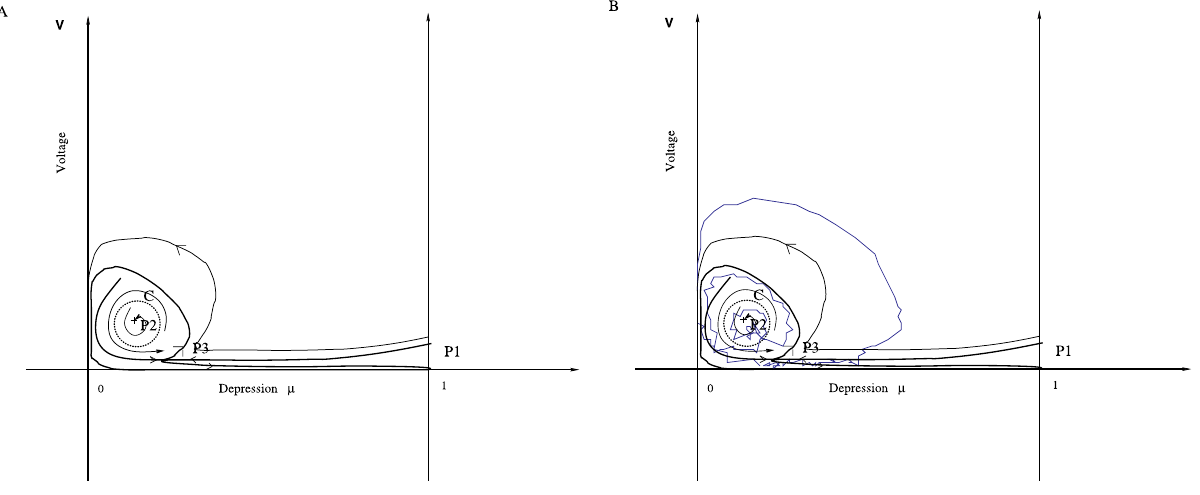
Figure 1. Schematic Representation of the Phase Space ( l ,V ) (A) The depression l is plotted on the x -axis, while the variable V is on the y -axis (for the schematic representation, no scale is given). The recurrent sets are the attractor points P 1 (the Down state), the saddle point P 3 , and the attractor P 2 (the Up state), separated by an unstable limit cycle C (dashed line). The region inside the unstable limit cycle is the basin of attraction of P 2 . By definition, it is the Up state. For a specific value of the parameter, an homoclinic curve can appear. The unstable branch of the separatrix starting from P 3 terminates inside the basin of attraction of the Down state. The noise drives the dynamics beyond the separatrices (lines with arrow converging to P 3 ) but a second transition is necessary for a stochastic trajectory to enter inside the Up state delimited by C. However a single noise transition is enough to destabilize the dynamics from the Up to the Down state. (B) Example of a trajectory in the phase space. DOI: 10.1371/journal.pcbi.0020023.g001 PLoS Computational Biology |